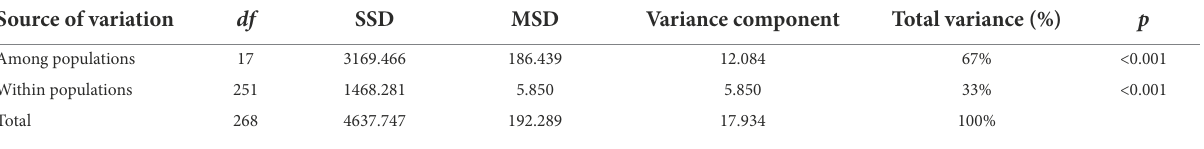
TABLE 2 Analysis of molecular variance (AMOVA) of E. breviaristatus based on EST-SSR. Source of variation df SSD MSD Among populations Within